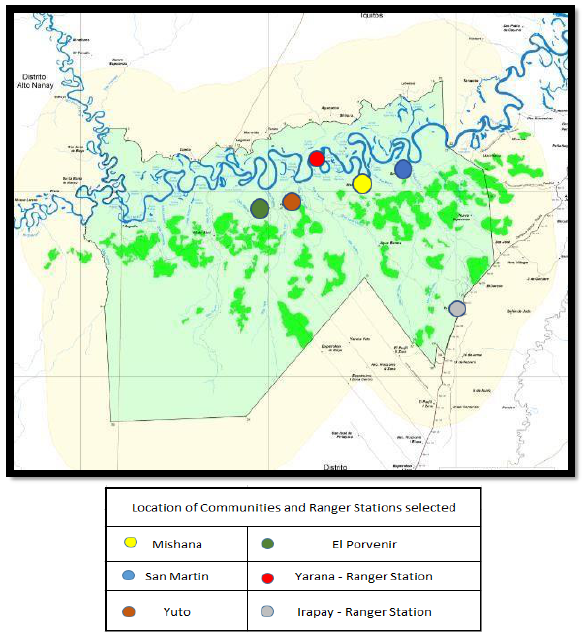
Figure 2 : Location of Indigenous Communities and Ranger